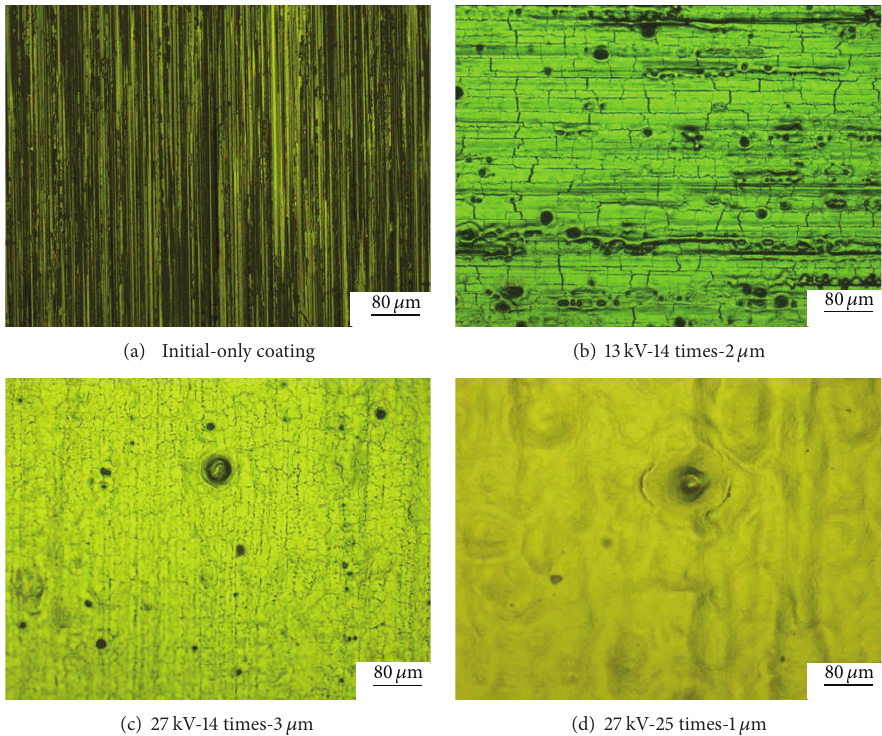
Figure 1: Surface morphology after electron beam treatment.